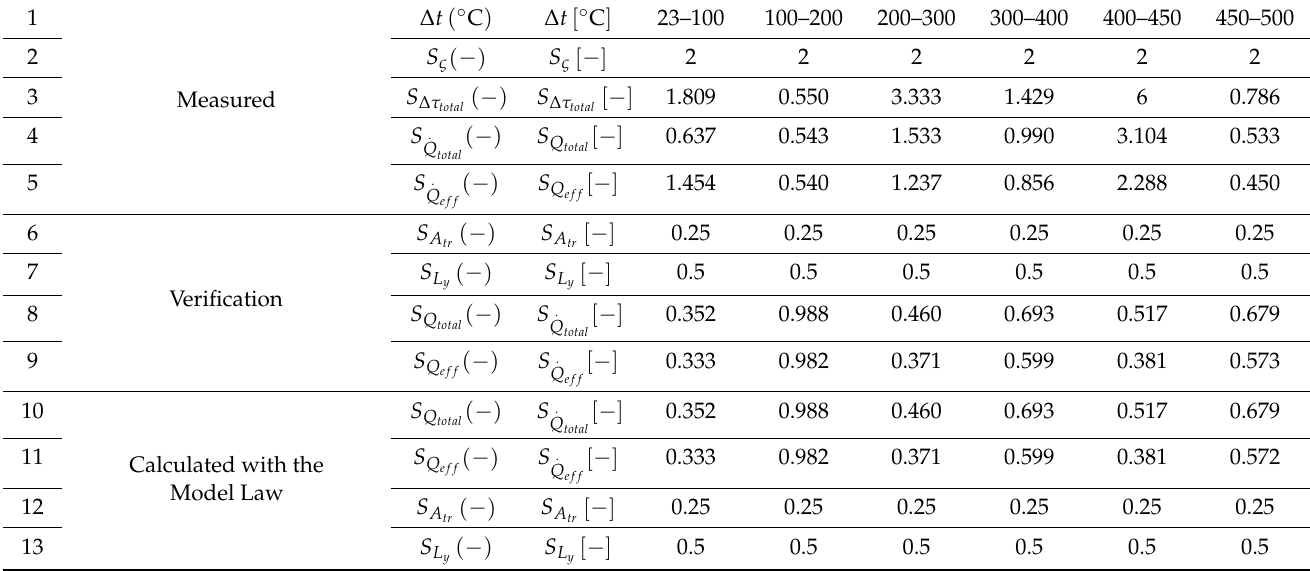
Table A6. The 1:4/1:2 unpainted model/prototype.